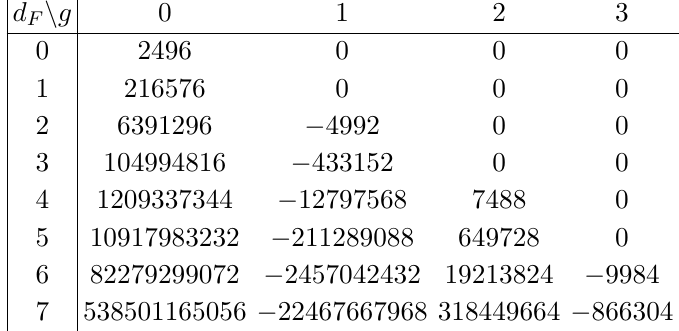
at base degree 2